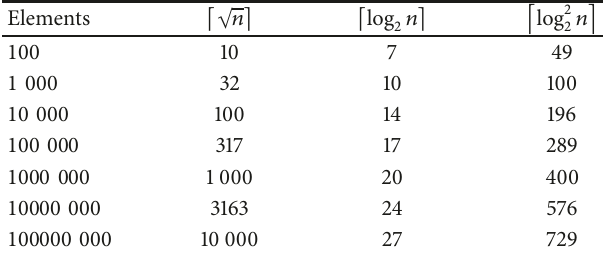
Table 5: Comparison of complexity for sorting operations.